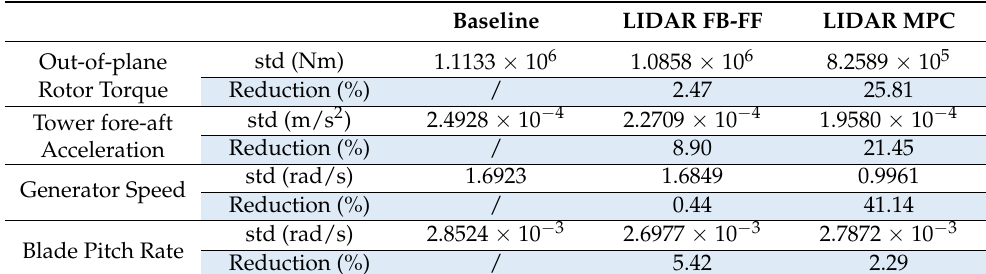
Table 4. Performance statistics for a wind speed with 10% turbulence intensity.